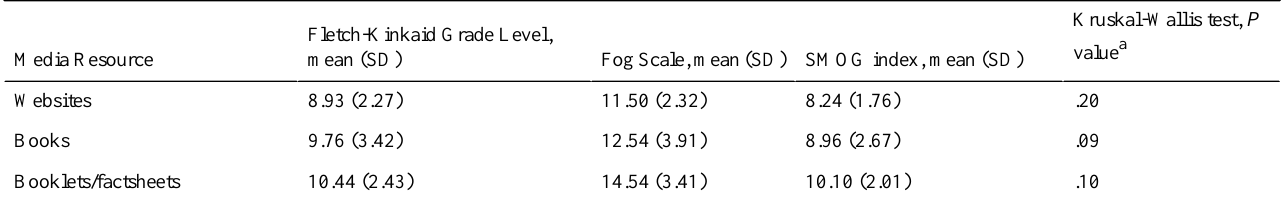
Table 1. Descriptive statistics and Kruskal-Wallis results for readability level.